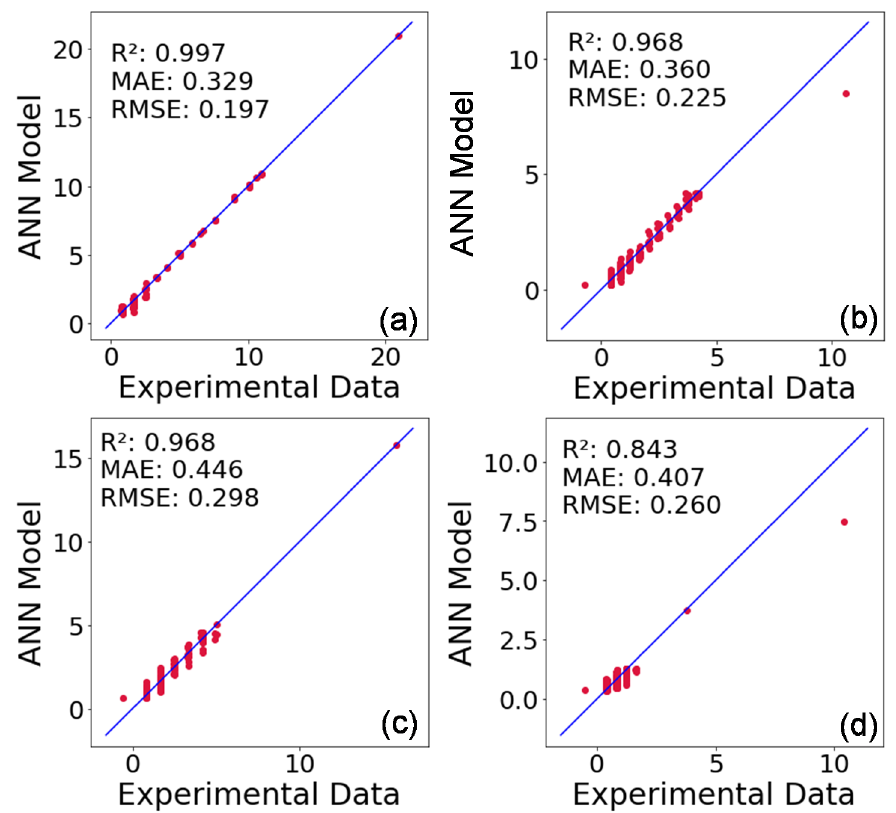
Figure 12. ANN models versus experimental data (for the heat of hydration in mW/g) with error metrics for ( a ) CEM I, ( b ) CEM I + GP, ( c ) CEM III, and ( d ) CEM III + GP.